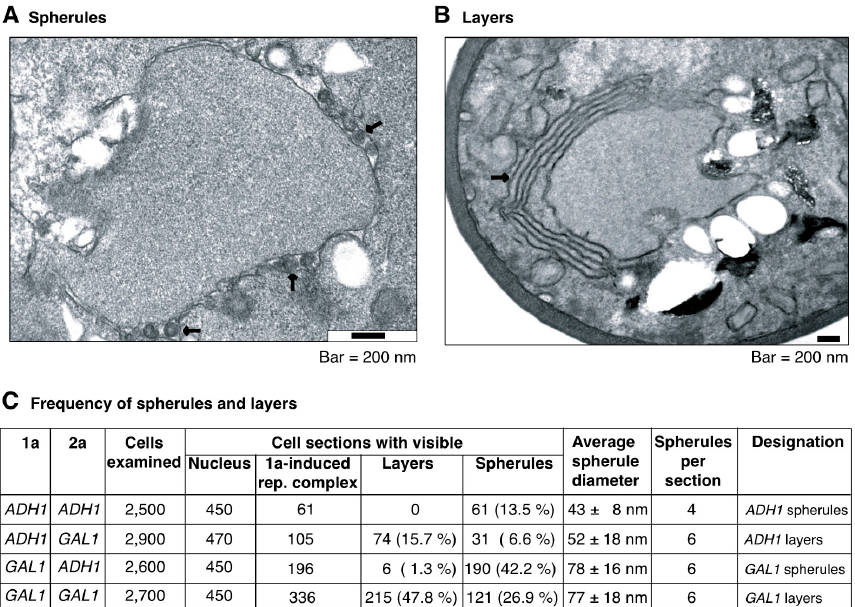
Figure 6. Alternate forms of BMV RNA replication compartments visualized by electron microscopy. ( A ) Arrows point to individual endoplasmic reticulum membrane-bound spherules; ( B ) The arrow points to rearrangement of the endoplasmic reticulum membrane in layers; ( C ) Expression of 1a and 2a pol from ADH1 or GAL1 promoters and the resulting membrane rearrangements. Number of cells examined, number of cells with a visible nucleus, and the number of cells with visible BMV replication compartments, are indicated for each 1a and 2a pol combination. The form of the replication compartment was classified as spherules or layers, and their relative abundance (%) is indicated with respect to the number of cells with visible nucleus. Within individual cells, spherules and layers were never detected together. The average spherule size and the average number of spherules per section is indicated. Spherules and layers were named based on the promoter driving expression of 1a.